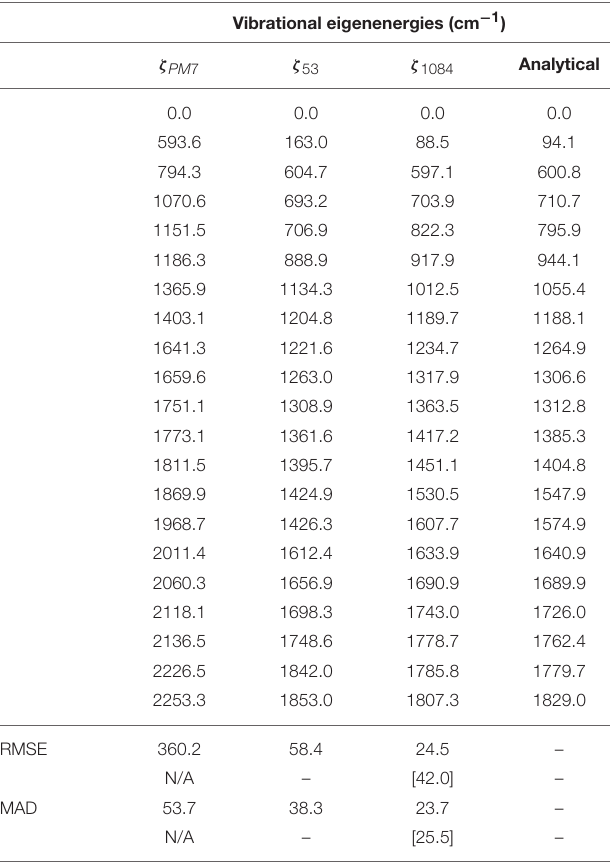
TABLE 5 | Comparison of the 20 lowest vibrational eigenvalues of HONO for different PESs denoted by its set of parameters, ζ N , where N is the number of points used in the fit (see Table 1